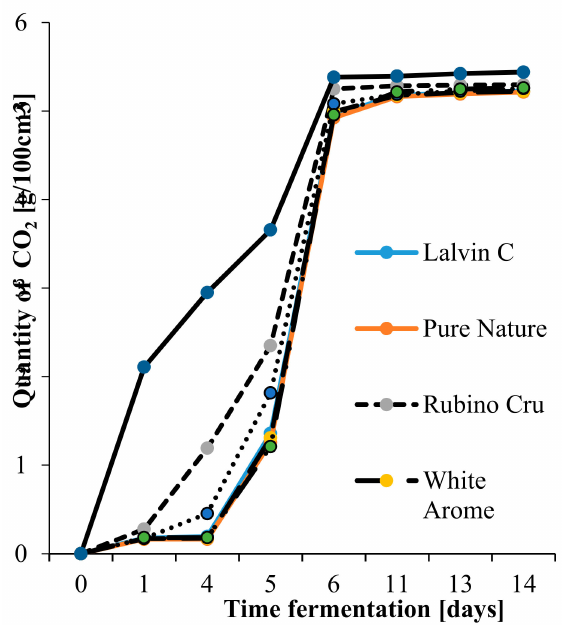
Figure 1. Dynamic fermentation in red apple